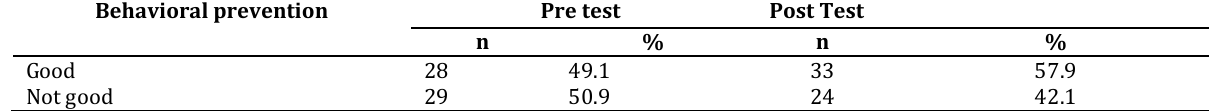
Table 2. Paired sample t-test before and after health education about gastritis (n=57) Counseling The mean P value Pre - test